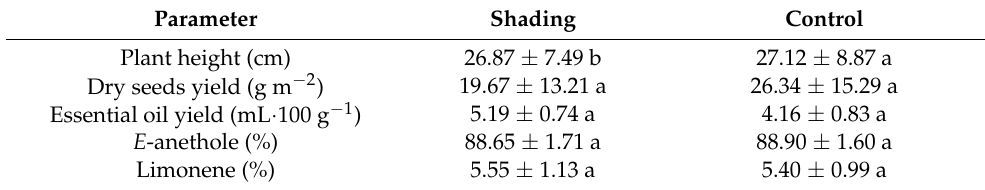
Table 7. Effects of shading (across fertilization application treatments) on growth parameters and essential oil main components (mean ± SD) of